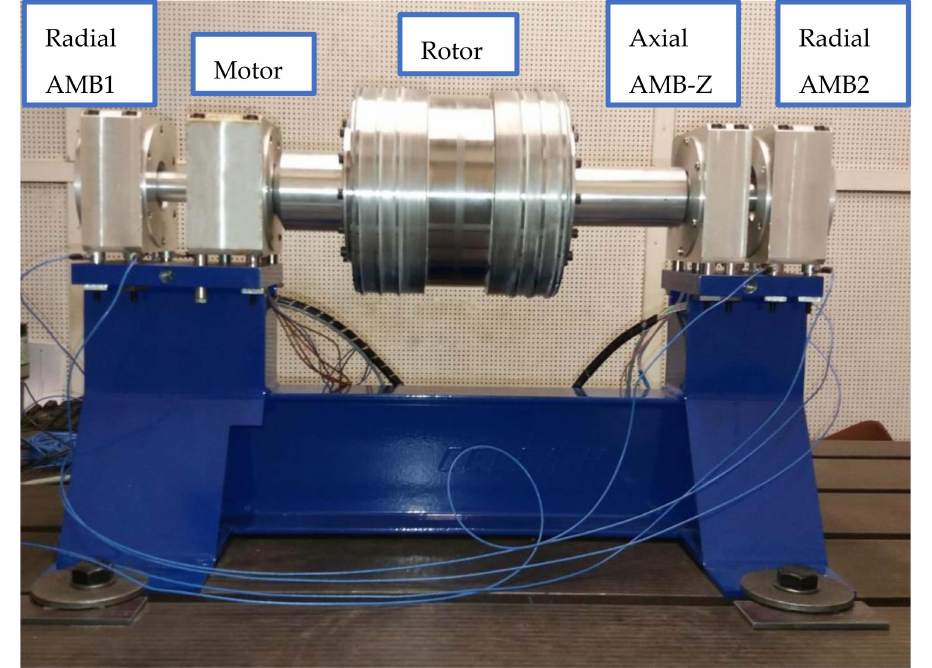
Figure 12. Experimental rotor supported by magnetic bearings. During the experiment, the levitation of the static rotor was stable using only the PID control of the AMB. The unbalance disturbances occurred when the rotor spin speed was increased. Field balancing with the use of trial weight was performed to balance the rotor. Figure 13 shows the STFT spectrogram of position signal in one AMB axis during run-up without AVC. The residual unbalance caused vibration of the rotor. The amplitude of vibration varies with speed up to approximately 12 µ m.